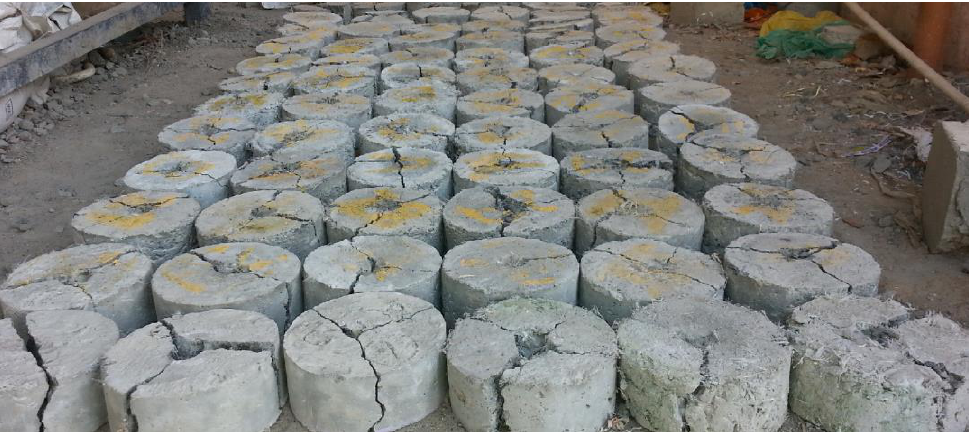
Figure 4. Tested specimens.